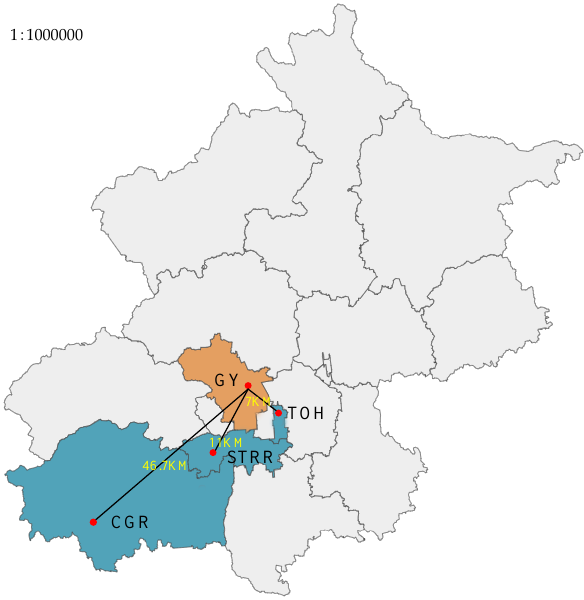
Figure 5. Distance between target area and other areas. The scale is 1:1,000,000. Table 1. Comparison of MI value and AID value between PM2.5 of GY and PM2.5 of TOH, STRR, CGR. TOH STRR CGR MI 0.71 0.56 0.43 AID 1.39 1.46 1.53